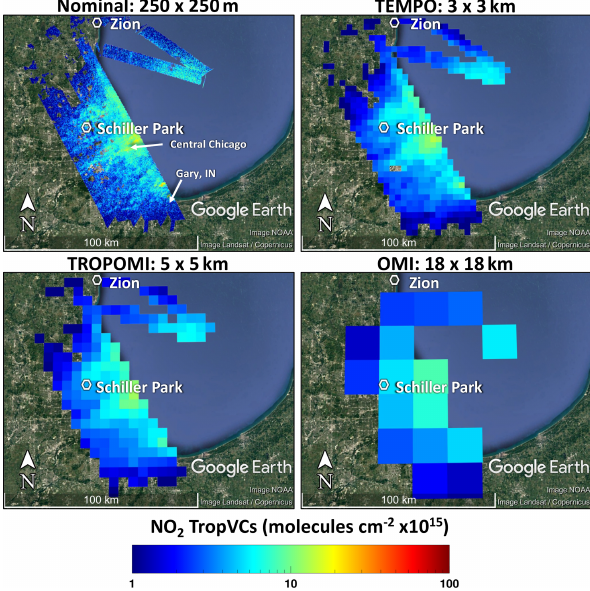
Figure 8. Maps of GeoTASO NO 2 TropVC on a log 10 color scale averaged to the labeled pixel sizes to demonstrate the spatial detail that would be observed from the midday raster in the Chicago area on 22 May 2017. All pixels shown have at least 30% of their area mapped by GeoTASO during this timeframe. Base map created in ©Google Earth